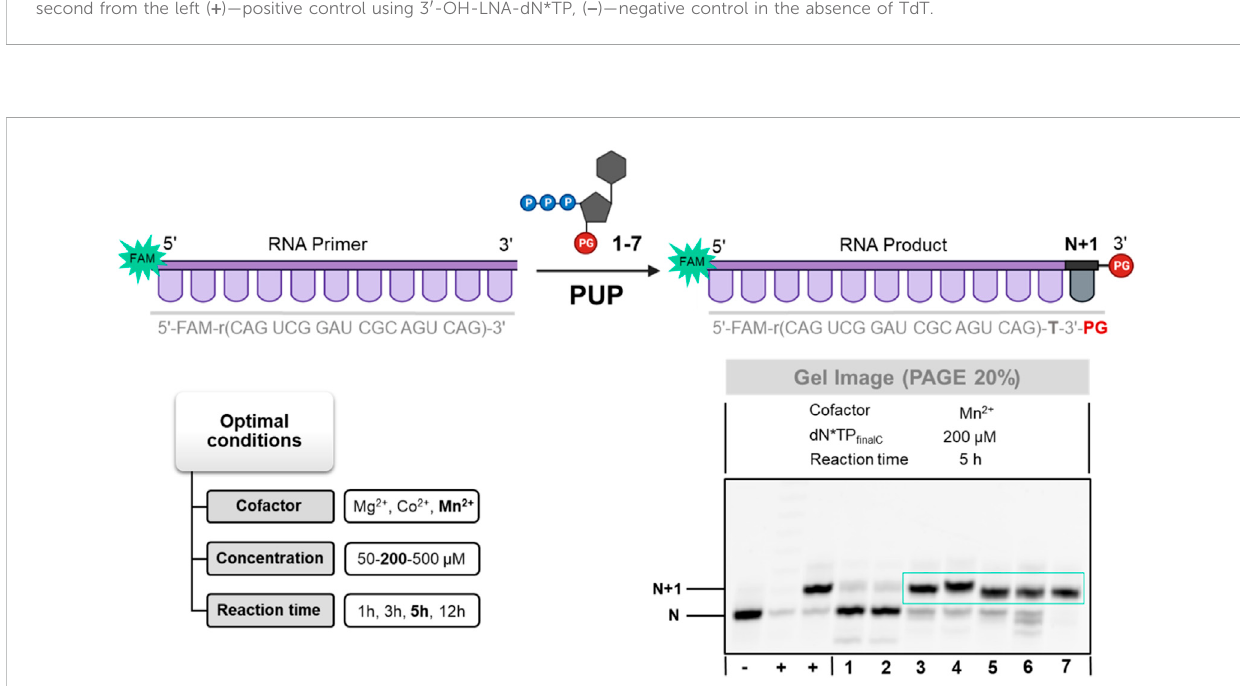
Gel image (PAGE 20%) of PUP-mediated tailing reactions with 3 ′ - O -protected dN*TPs 1 – 7 . First from the left ( + ) — positive control using rUTP, second from the left ( + ) — positive control using 3 ′ -OH-LNA-dN*TP, ( − ) — negative control in the absence of